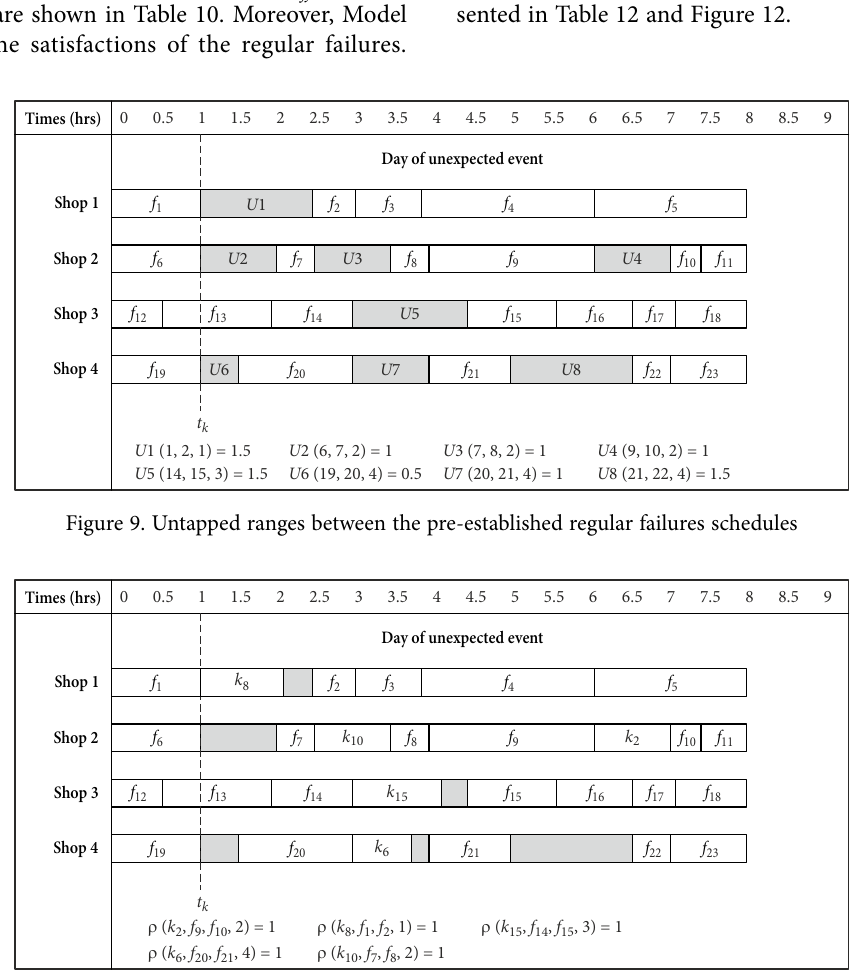
Figure 10. Emergent failures Table 9. General inputs for Model III Table 10. The precedence between regular failures in shop 4 The precedence between regular failures in shop 4 The readiness Failure ( f ) time, rt f